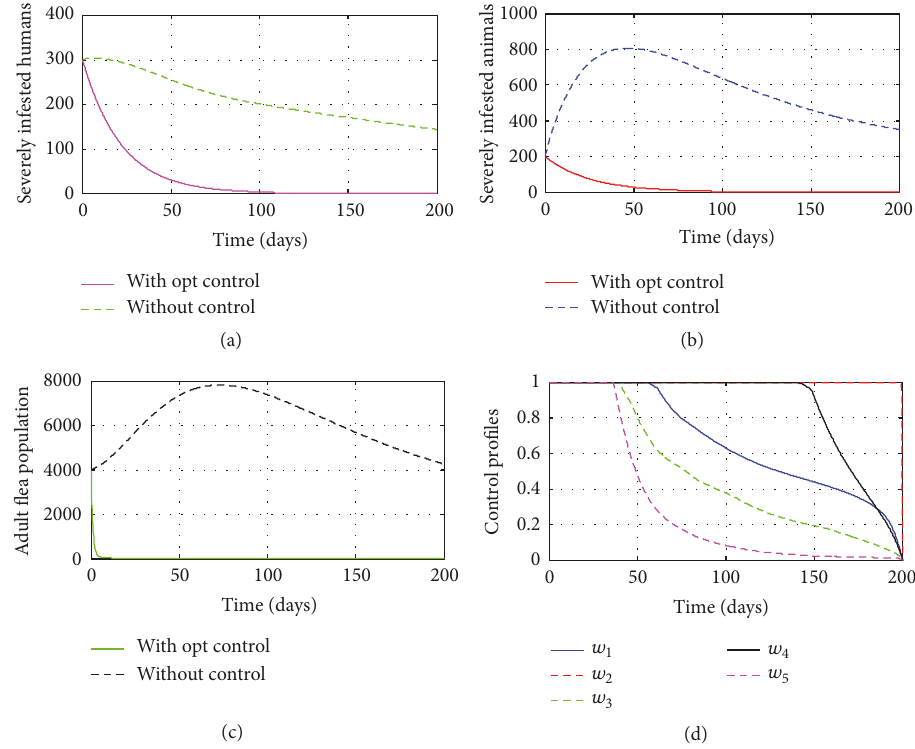
Figure 3: Optimal solutions for model variables 𝐼 𝐻ℎ , 𝐼 𝐴ℎ , 𝐹 𝐸 and the control profiles for 𝑤 1 , 𝑤 2 , 𝑤 3 , 𝑤 4 , 𝑤 5 with (𝑤 1 , 𝑤 2 , 𝑤 3 ,𝑤 4 ,𝑤 5 ̸= 0) .